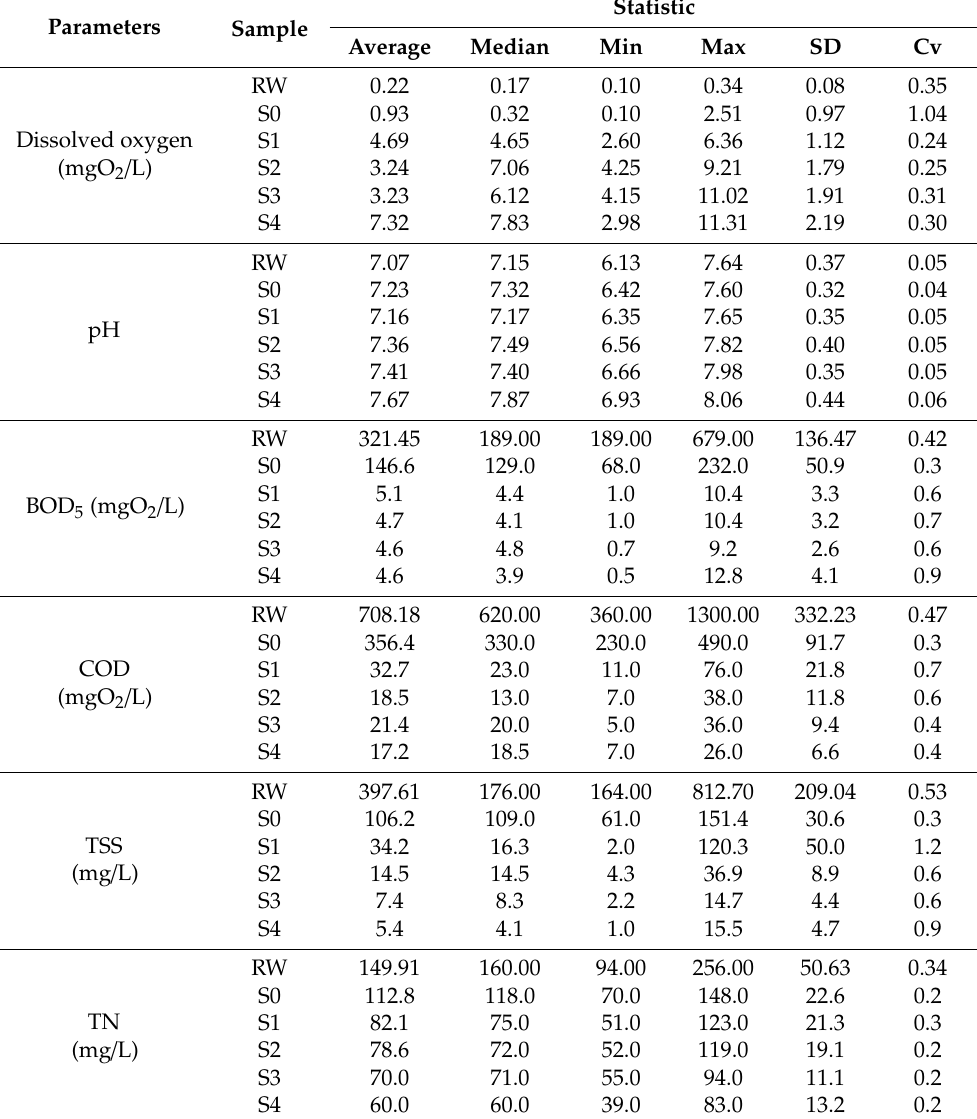
Table 2. Contaminant concentrations at the individual stages of treatment in the SSVF-SSHF- SSHF-SSVF